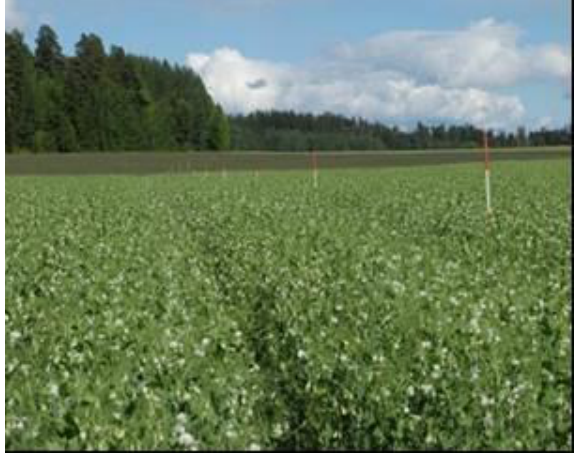
Figure 6 Aphid infected pea field. Photo: Anne Nissinen